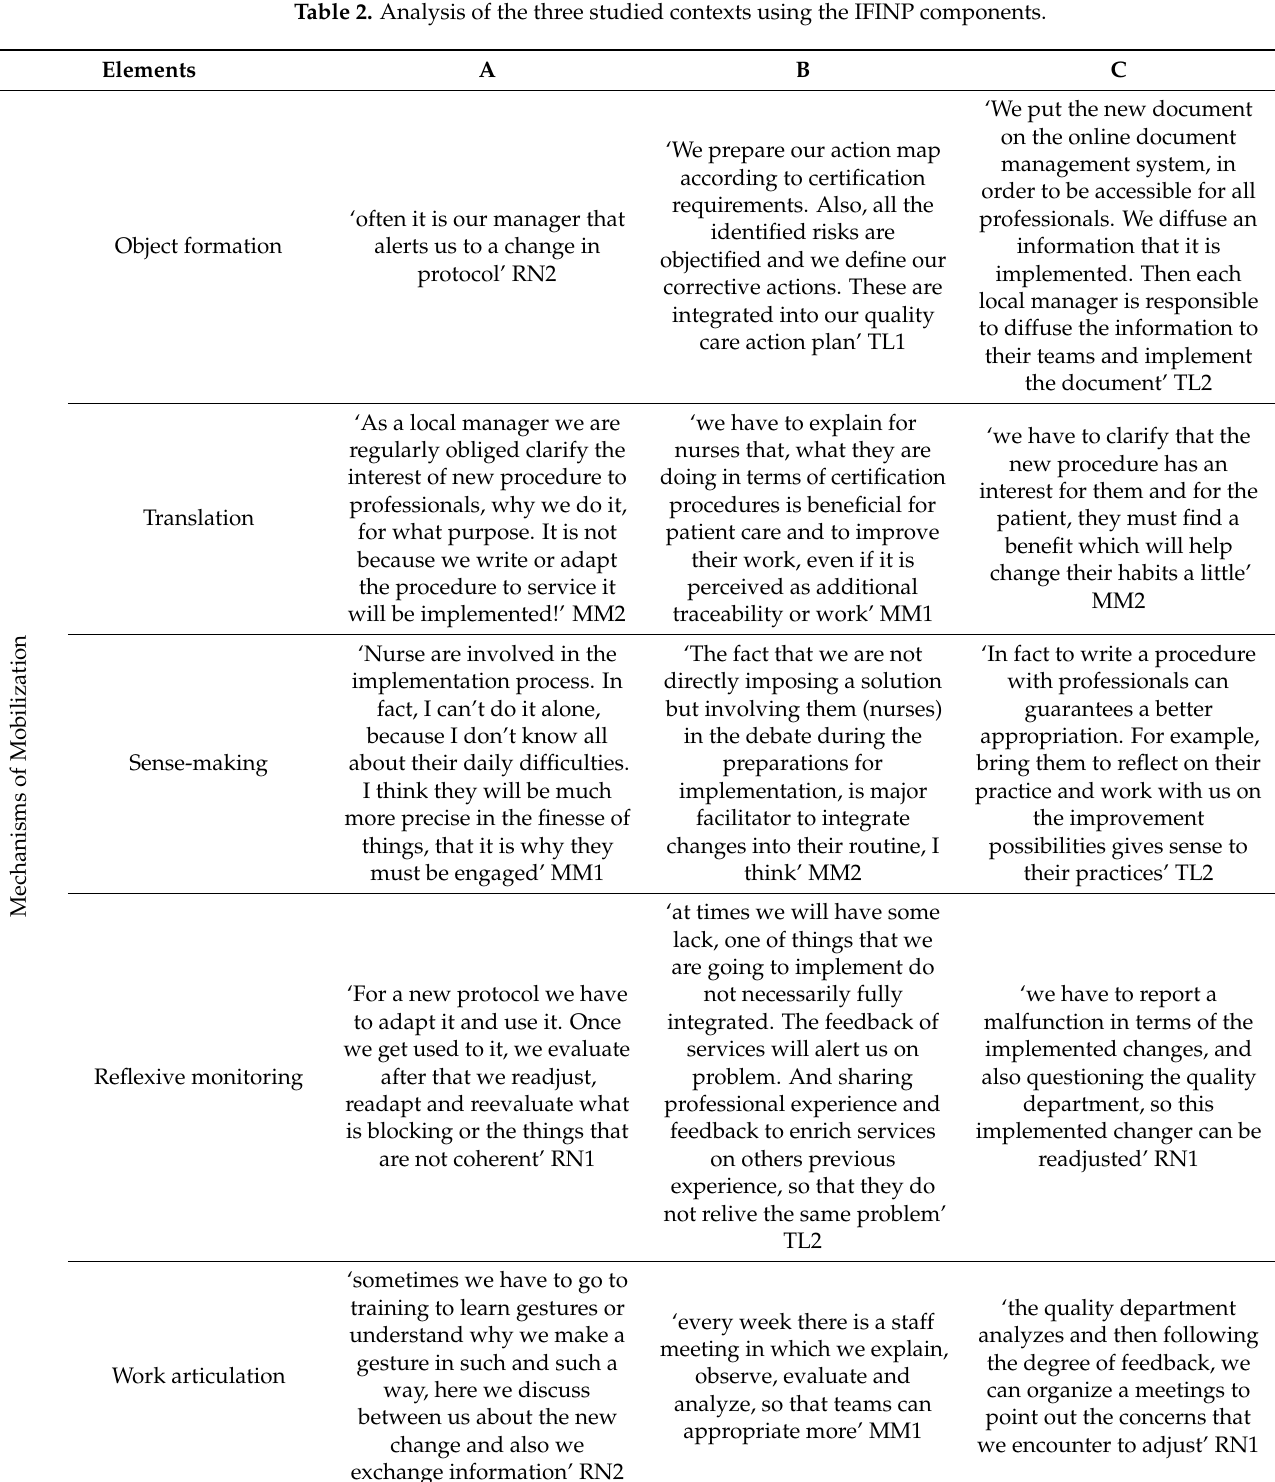
Table 2. Analysis of the three studied contexts using the IFINP